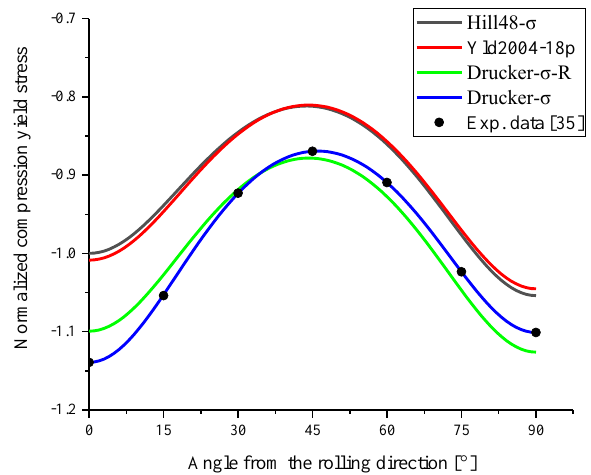
Figure 14. Predicted tensile r-values and experimental (virtual) data.